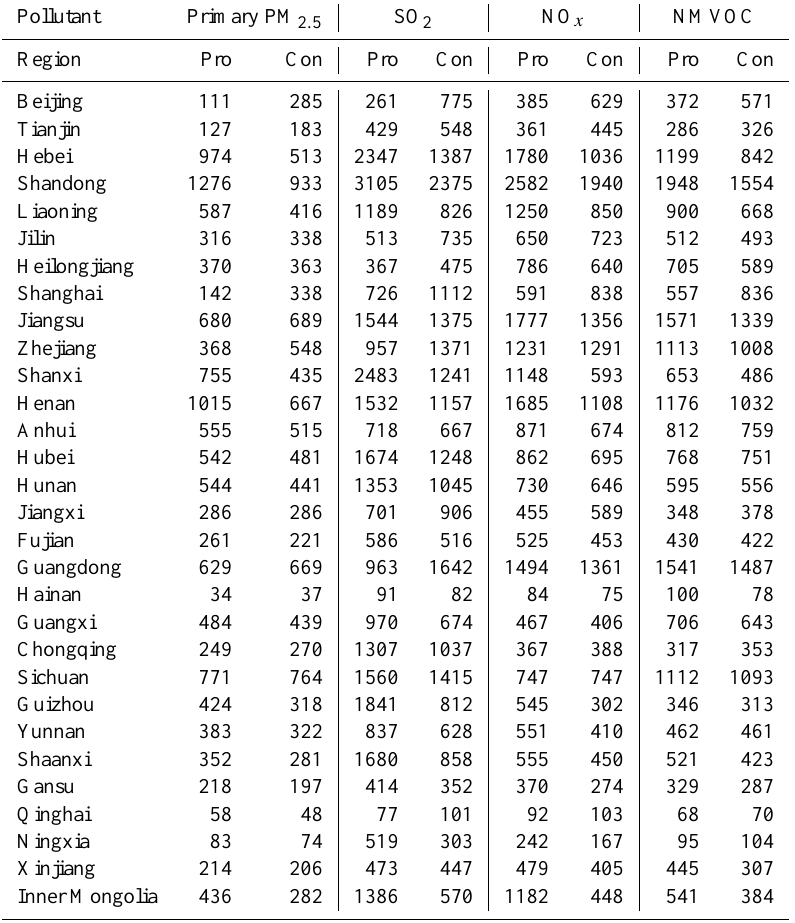
Table 1. Comparison of regional pollutant emissions from production- and consumption-based emissions (Ggyear − 1